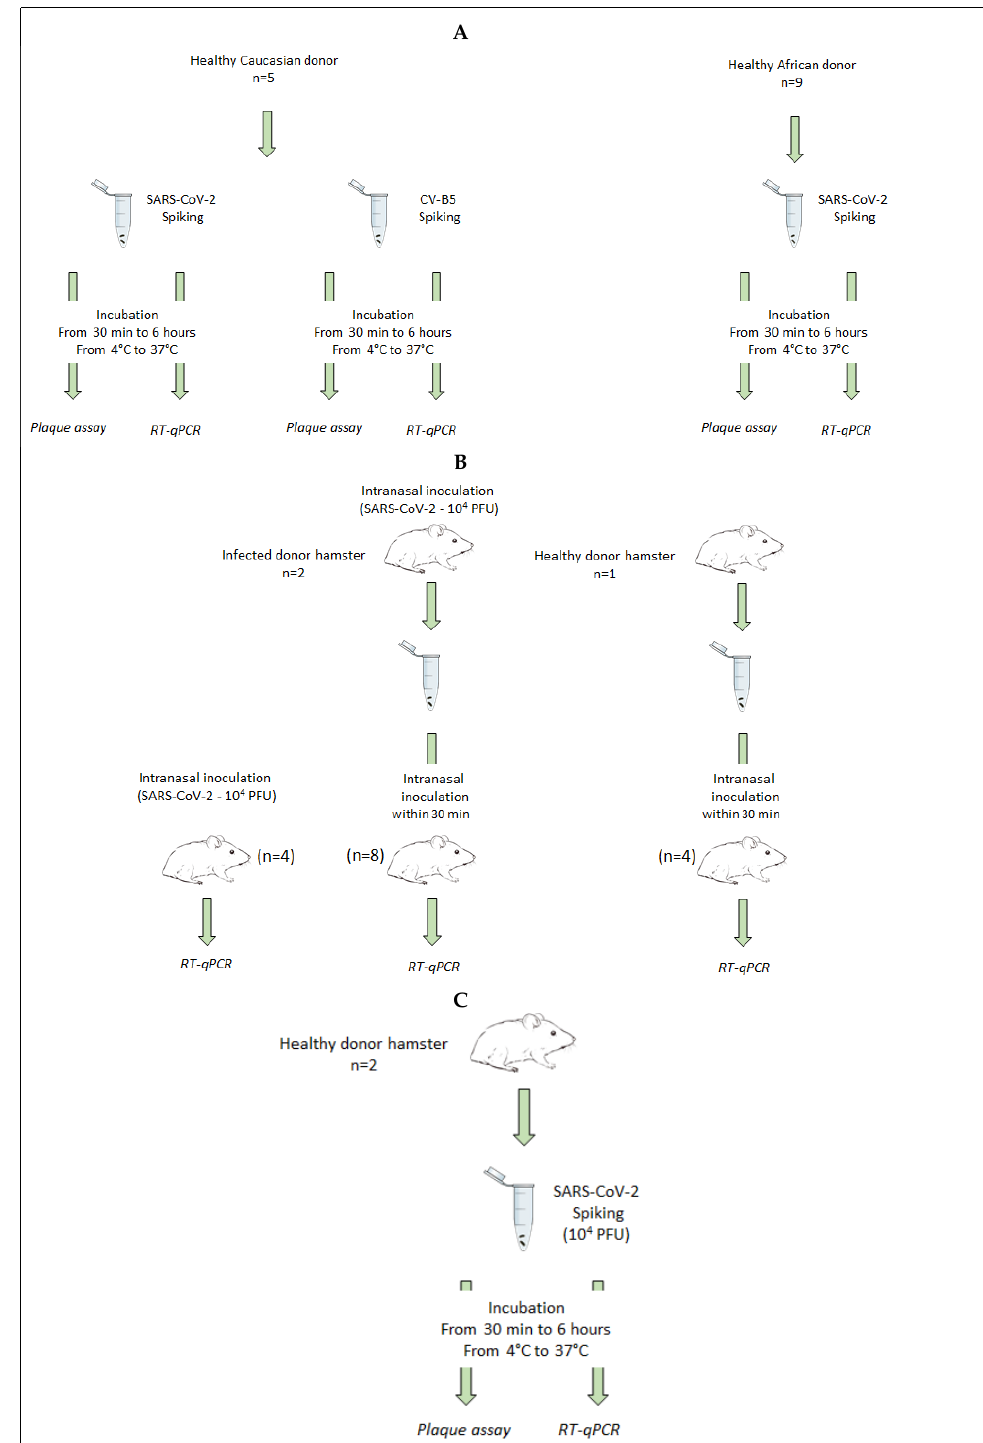
Figure 1. Experimental design used to evaluate the viral infection from contaminated (naturally or experimentally) feces. ( A ) Effect of incubation time and temperature on the persistence of viral genome and infectious virus in human stools from healthy donors by RT-qPCR and plaque assay, respectively. ( B ) Infection transmission after exposure to fresh feces from infected donor hamsters and persistence of the virus shedded in the feces by endpoint plaque assay and RT-qPCR. ( C ) Infection transmission after exposure to spiked fresh feces from healthy donor hamsters and effect of incubation time and temperature on the persistence of the virus spiked in fresh feces by endpoint plaque assay and